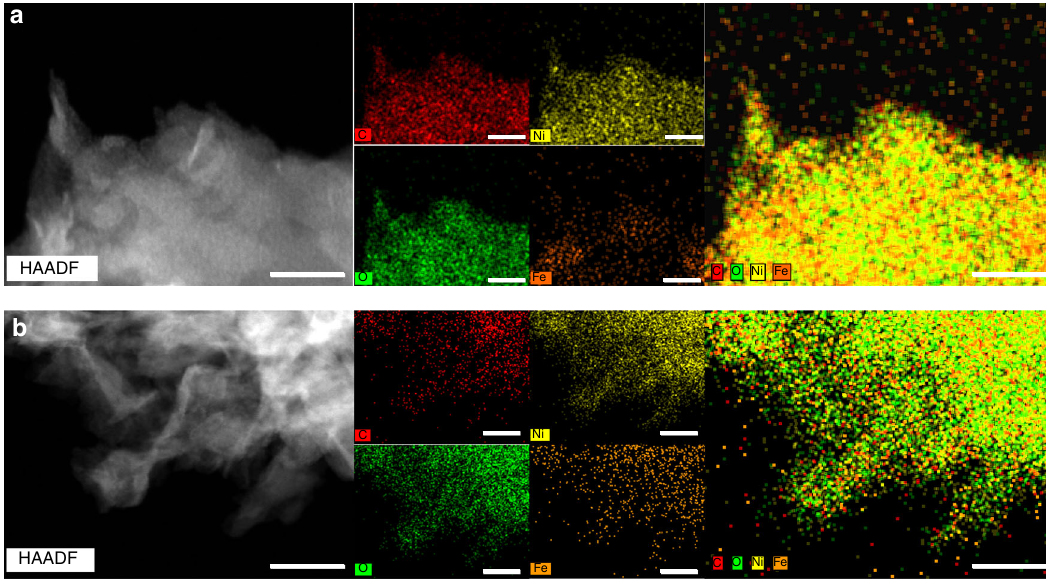
Fig. 3 HAADF-STEM images and corresponding elemental mappings of NiFeCP/NF . Particles detached by sonication from a as prepared NiFeCP/NF electrode and b the electrode after OER test. The scale bars are 30 nm